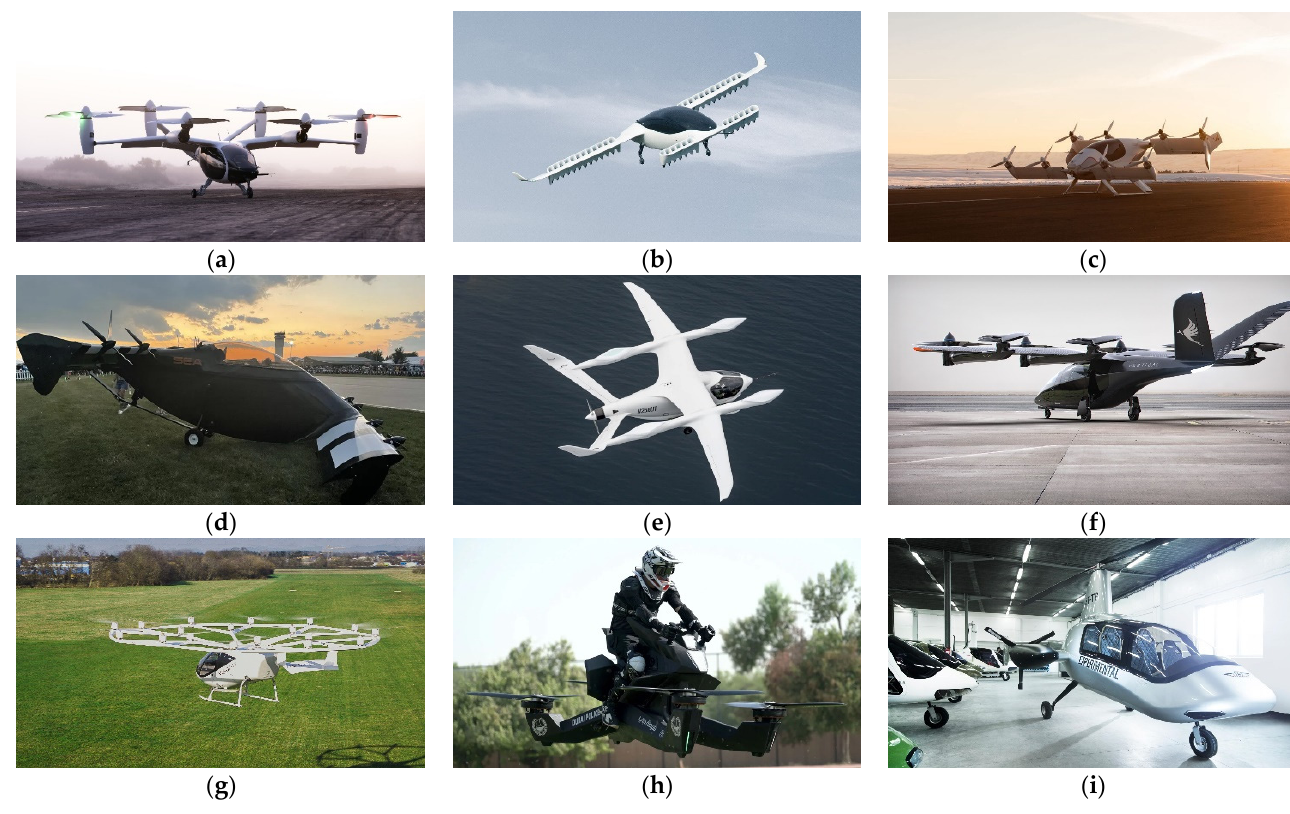
Figure 2. Select eVTOL aircraft with highlighted propulsion configurations: ( a ) Joby Aviation eV- TOL [51], Powered Lift, Vectored Thrust (Tilt Prop); ( b ) Lilium Jet [50], Powered Lift, Vectored Thrust (Tilt Fan); ( c ) Airbus (Acubed) Vahana [54], Powered Lift, Vectored Thrust, (Tilt Wing); ( d ) Opener Blackfly [53], Powered Lift, Vectored Thrust, (Tilt Body); ( e ) Beta Technologies Alia [55], Powered Lift, Independent Thrust, (Lift + Cruise); ( f ) Vertical Aerospace VX-4 [56], Powered Lift, Combined Thrust, (Tilt Prop); ( g ) Volocopter VoloCity [57], Wingless, Multicopter; ( h ) Hoversurf Scorpion 3 [58], Wingless, Hoverbike; and ( i ) Aviation Artur Trendak T6 [59], Wingless, Electric Rotorcraft